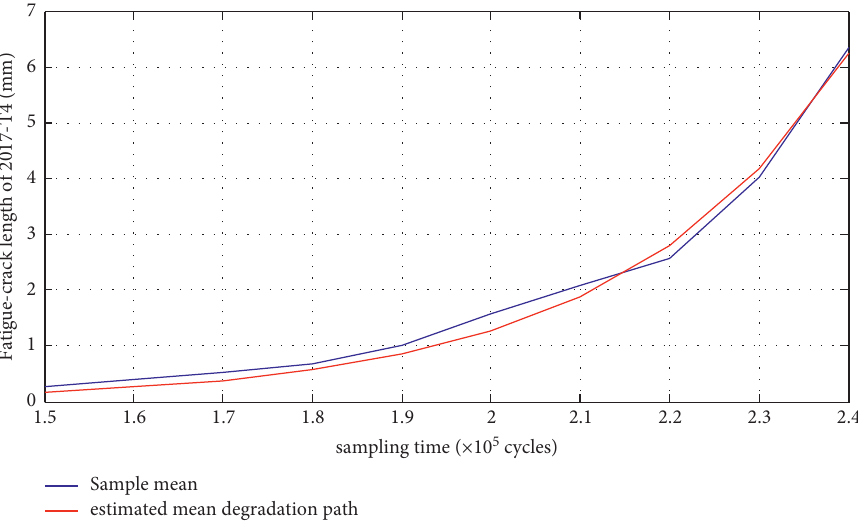
Figure 2: Comparison of the sample mean curve and the estimated mean degradation path. Table 1: Correlation coefficients of different fitting